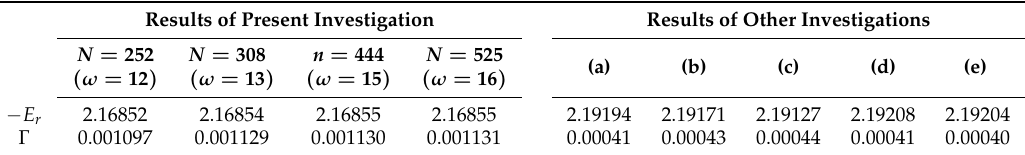
Table 1. Resonance energy E r (in a.u.) and width Γ (in a.u.) in He − ( 1 s 2 s 2 2 S ) for µ = 0. (a) Method of complex coordinate rotation [21]; (b) R-matrix method [22]; (c) complex stabilization method [27];